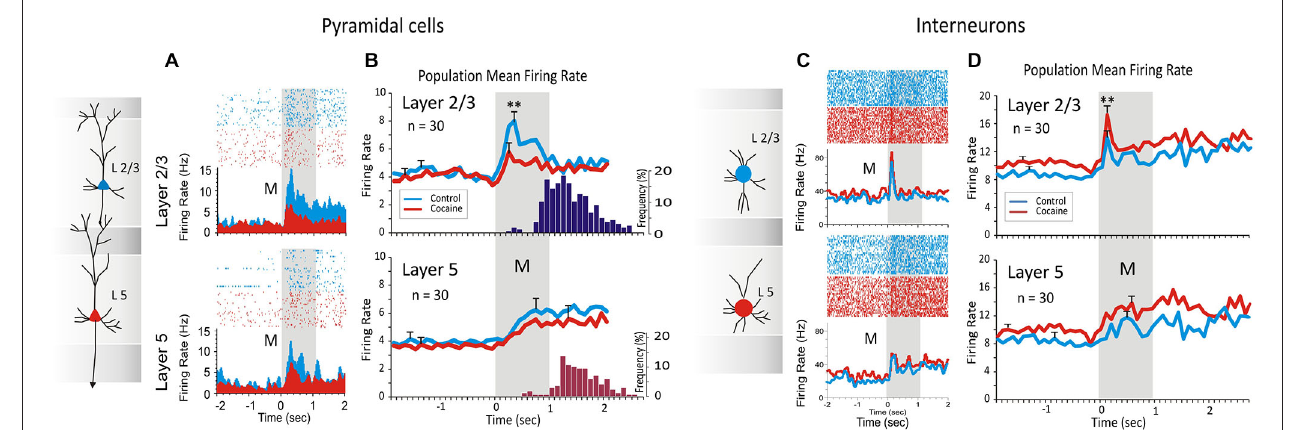
layer 5 (red) PFC cell pairs ( n = 30) in sessions in which cocaine was administered, as shown in Figure 1B . Dark blue and red histograms on the right show average distribution of MR latencies relative to Match phase onset (M, 0.0 s) for control and cocaine trials respectively, within the same sessions. (C) Raster-PEHs show firing of layer 2/3 and 5 interneurons in the Match phase during the control (saline) half of the session (blue) vs. cocaine administration midway through the session (red). (D) Average PEHs for control (upper) vs. cocaine trials (lower) summed over all fast spiking interneurons ( n = 30) in layer 2/3 (blue) and layer 5 (red) recorded in the same sessions. (** p < 0.01, ANOVA). Panels (A) and (B) are adapted with permission from Opris et al.